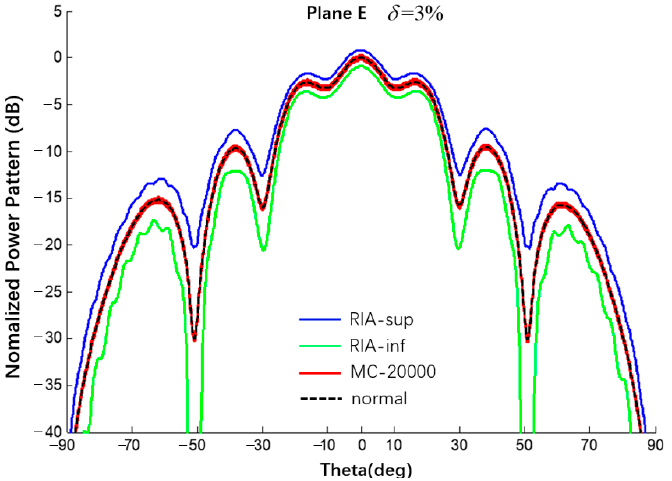
Figure 20. Interval power pattern of excitation amplitude error of spherical CAAs (Plane E, uniform excitation, the tolerance of MC method is 3%). Table 5. Numerical results of SLL of power pattern in Figures 19 and 20.